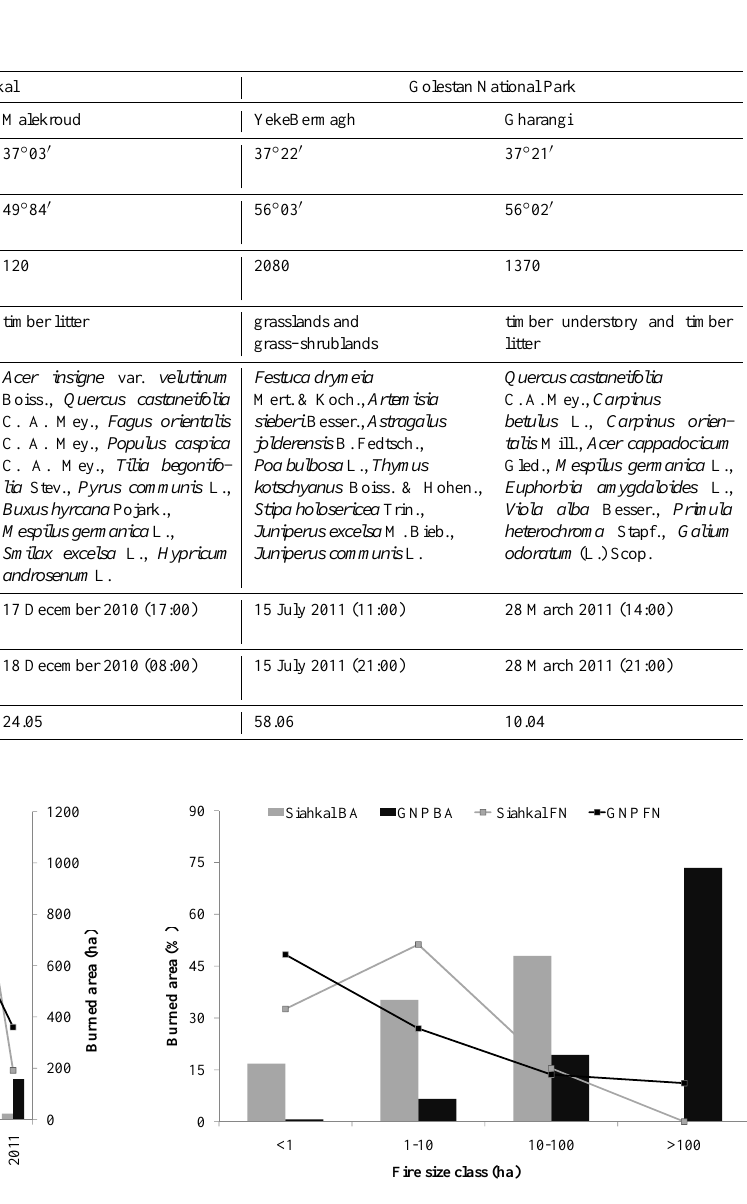
Figure 3. Fire number (FN) and burned area (BA) in Siahkal for-